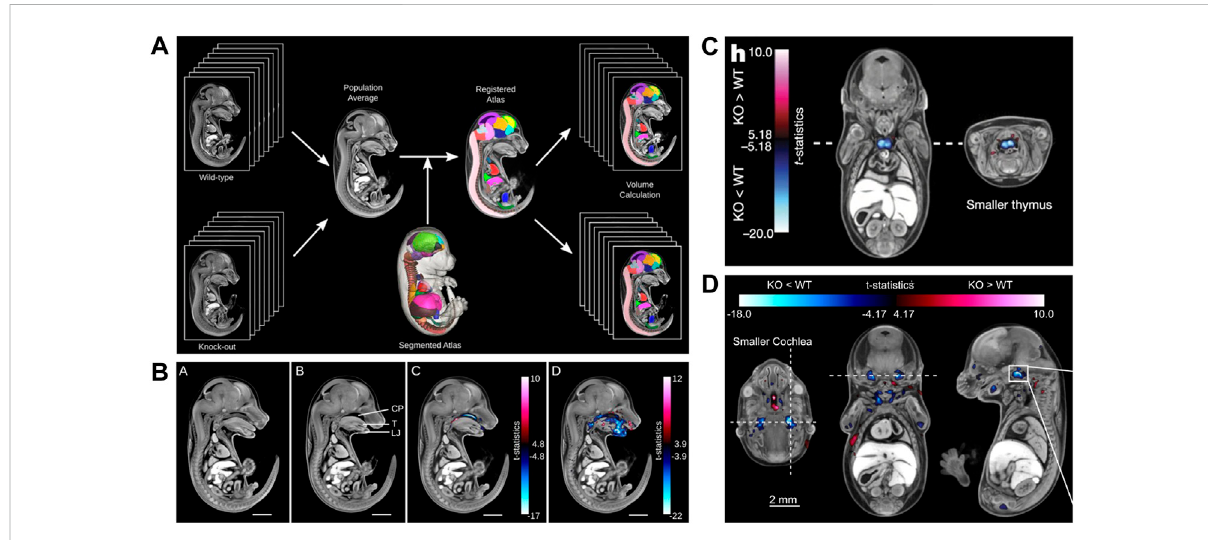
FIGURE 7 MicroCT for automated detection of novel phenotypes. (A) Automated image analysis pipeline using a microCT data-derived segmented mouse embryo atlas to detect developmental malformations [Figure 2 from Wong et al., 2014, Development 141 (12)]. (B) Automated detection of gross phenotypes by intensity- and deformation-based analysis in Satb2 knockout mice (Figure 6 from Wong et al., 2014, Development 141 (12)). (C) Automated detection of subtle phenotypes, demonstrated on small thymus volume in E15.5 Cbx4 knockout mice (parts of Figure3H from Dickinson et al., 2016, Nature 537). (D) Automated detection of subtle phenotypes, demonstrated on small cochlear volume in E15.5 Eya4 mutant embryos(ExtendedDataFigure6DfromDickinsonetal.,2016,Nature537).AandBreprintedbypermissionfromtheCompanyofBiologists.CandD reprinted by permission from Springer